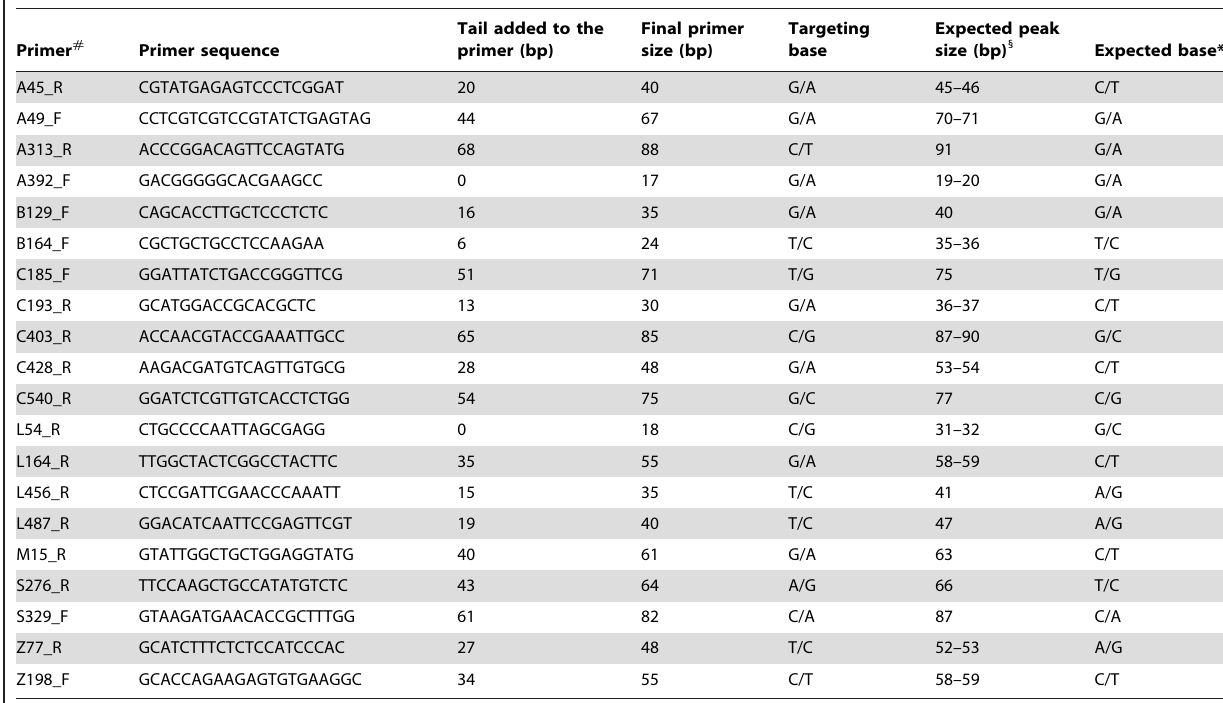
Table 2. The primers used in SNaPAfu